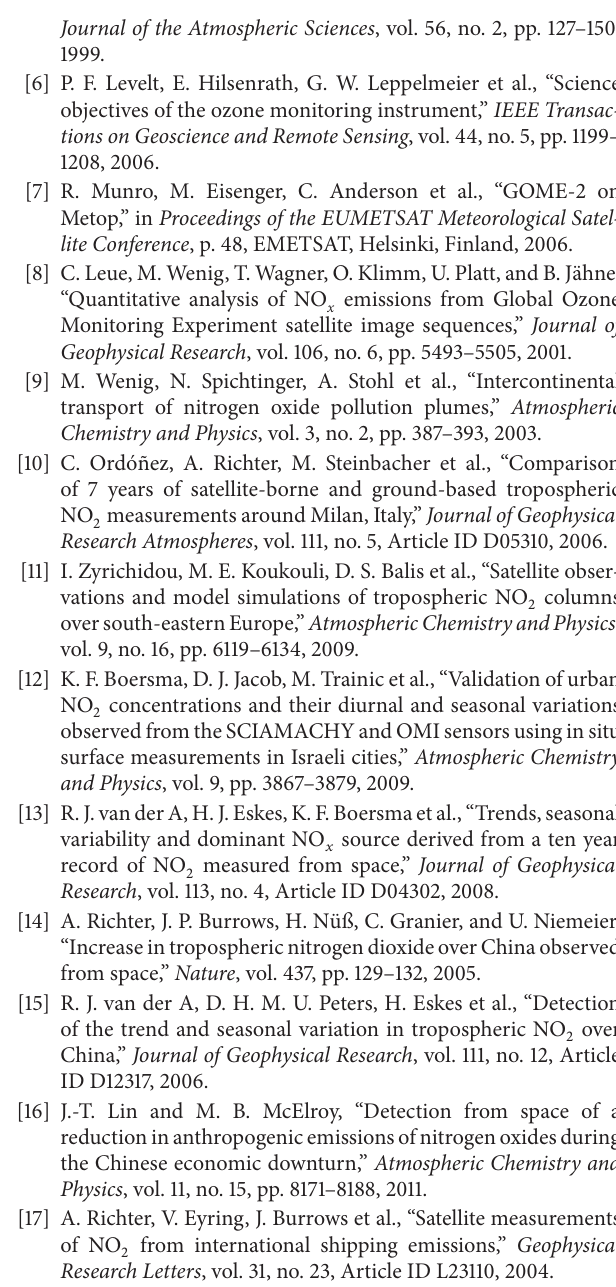
observations and their significance (bottom) for 2